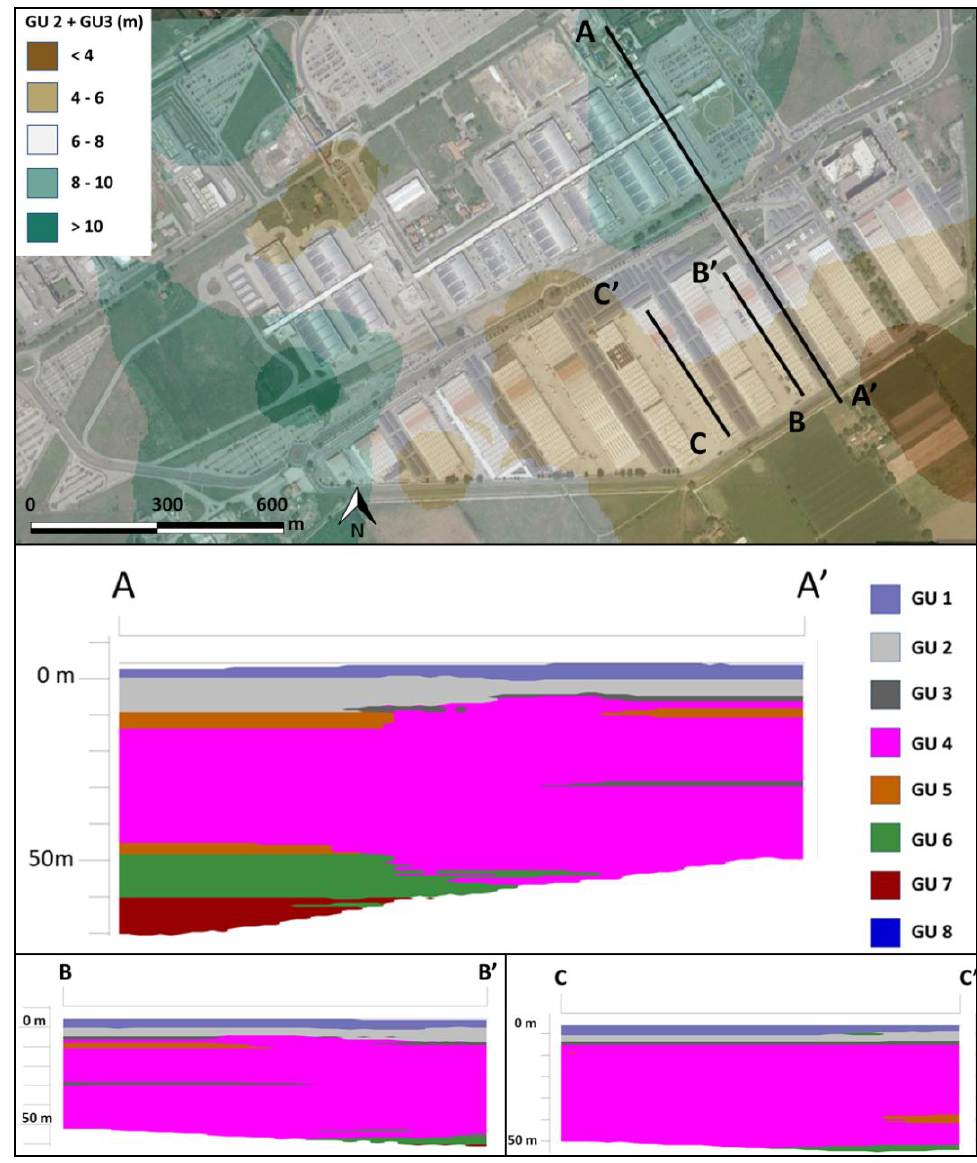
Figure 8 . A detail of sector 1. GU2 + GU3 thickness map and geotechnical cross sections (with a strong vertical exaggeration) of the Rome Fair and Commercity region. Table 3 . Main geotechnical parameters of the compressible units present in the Commercity/Rome Fair region (Cu, undrained shear strength; Cv, consolidation index; CR, compression ratio; RR, recompression ratio; OCR, over-consolidation ratio; Φ , friction angle; c’ , effective cohesion). Geotechnical Unit